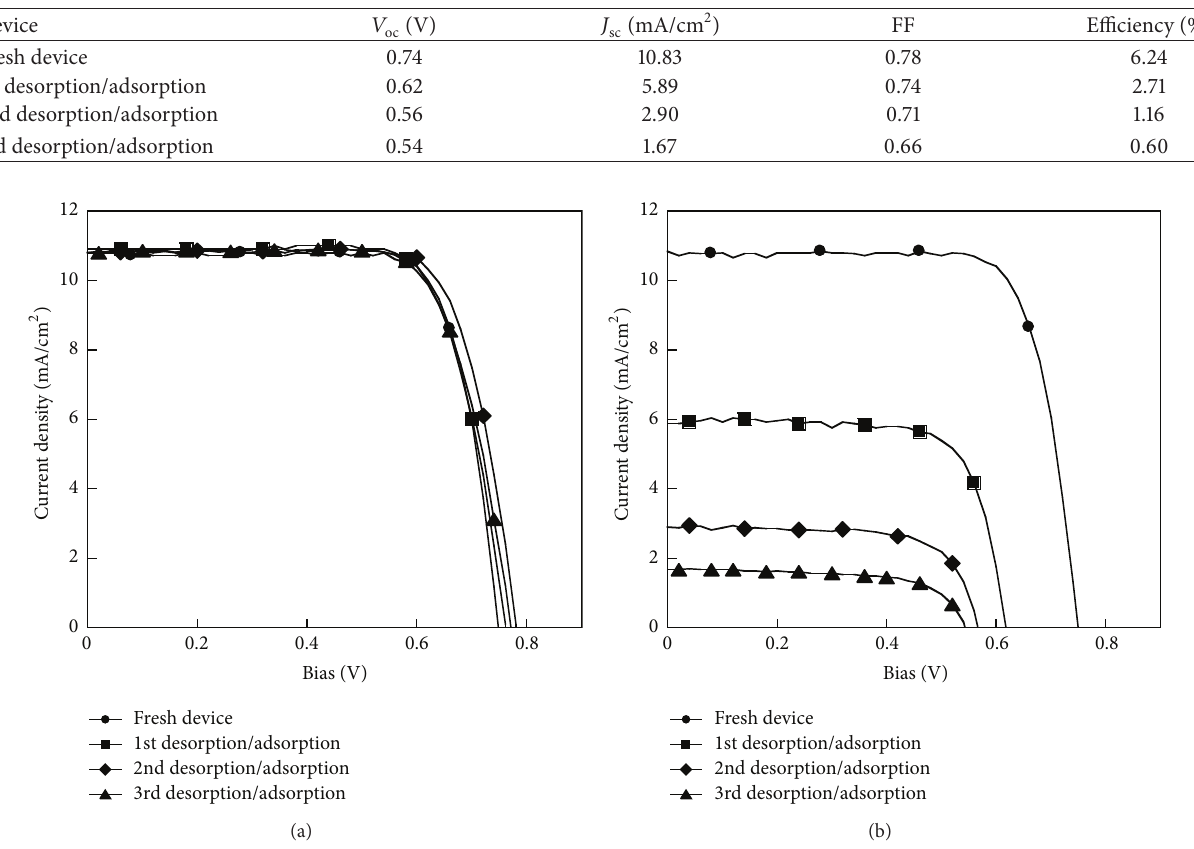
Figure 3: 𝐽 - 𝑉 characteristic curves of fresh DSCs and devices that had undergone multiple adsorption/desorption processes using (a) NaOH and (b) CH 3 COOH solutions as desorption agents under AM 1.5G, 100mW/cm 2 illumination.